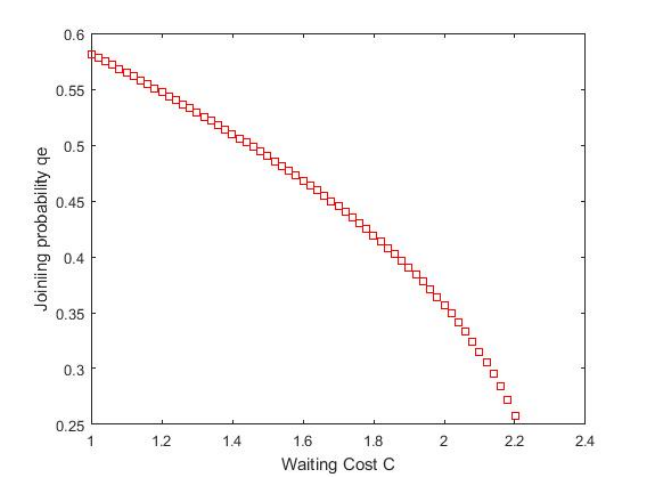
Figure 10. Equilibrium-joining probabilities vs. C when α = 0.2, β = 0.5, λ = 0.4, µ = 1, θ = 0.7, η = 0.5, R = 15.